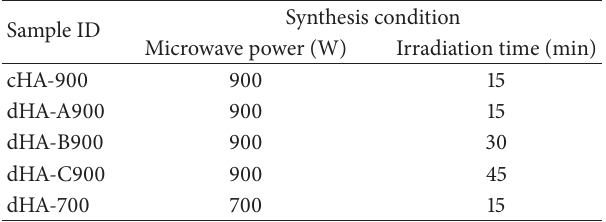
Table 1: Sample ID and synthesis condition in the synthesis of